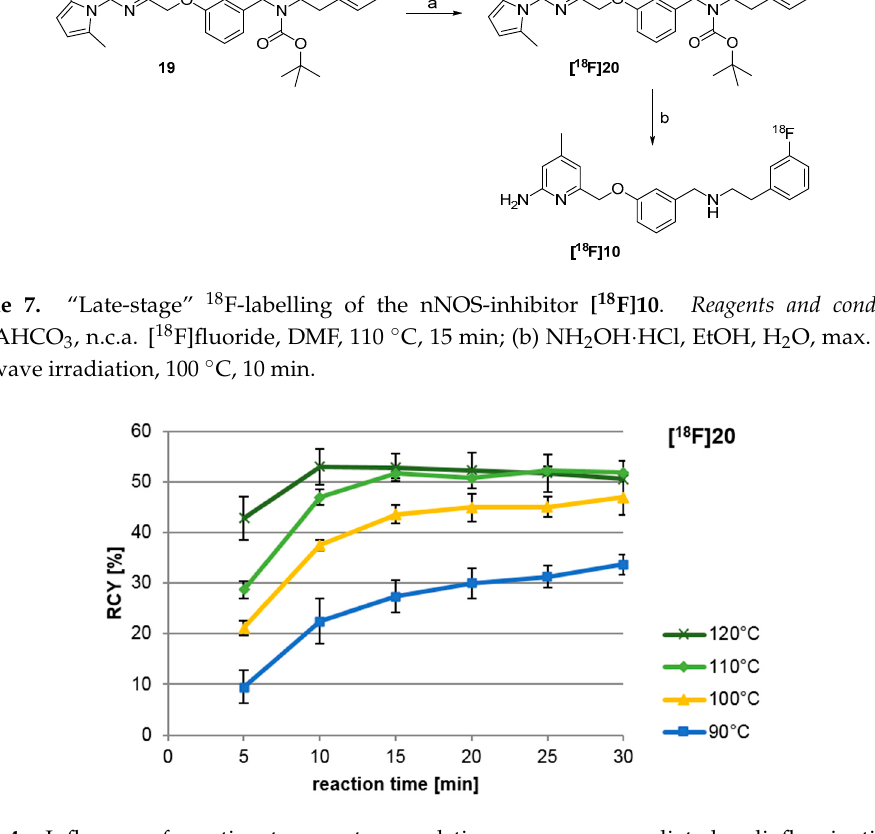
Figure 4. Influence of reaction temperature and time on copper-mediated radiofluorination of precursor 19 . All syntheses were carried out manually and RCY was determined by radio thin layer chromatography (TLC). Each experiment was carried out at least in triplicate. Reagents and conditions : 30 μ L MeCN, 10 mg (15 μ mol) 19 , 3.5 mg (5 μ mol) Cu II OTf 2 py 4 in 300 μ L DMF.